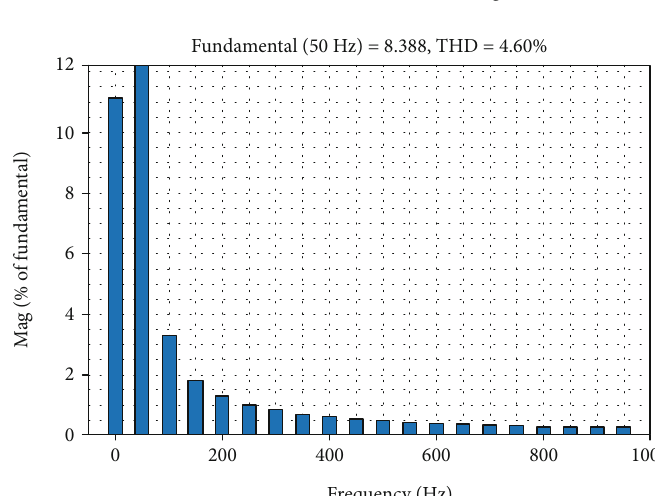
Figure 36: THD values for FC voltage.